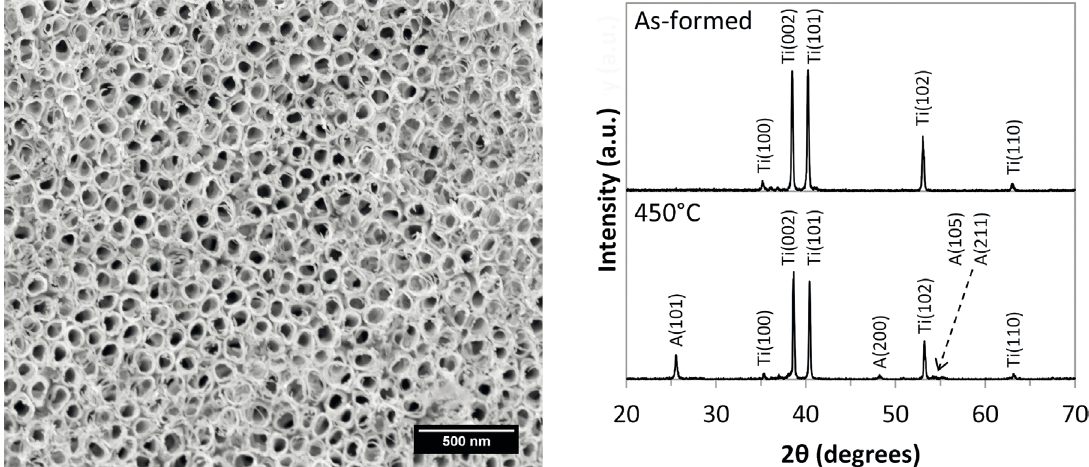
Figure 2. SEM micrograph and XRD pattern of the nanotubes layer after annealing at 450°C, along with XRD pattern of the as-formed condition.